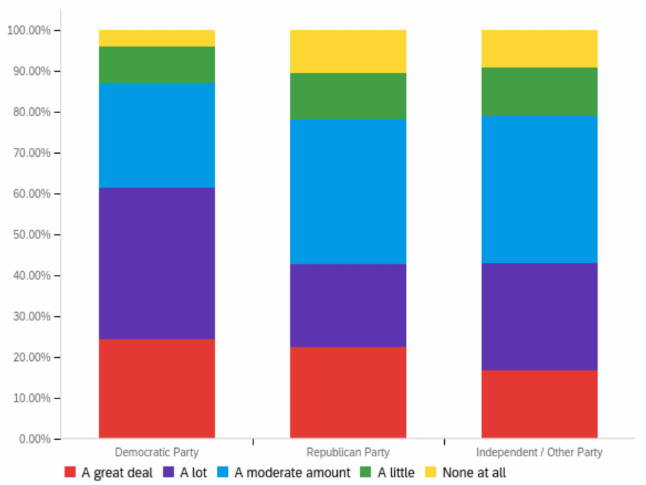
Figure 3. Article author—ideal perception impact by political